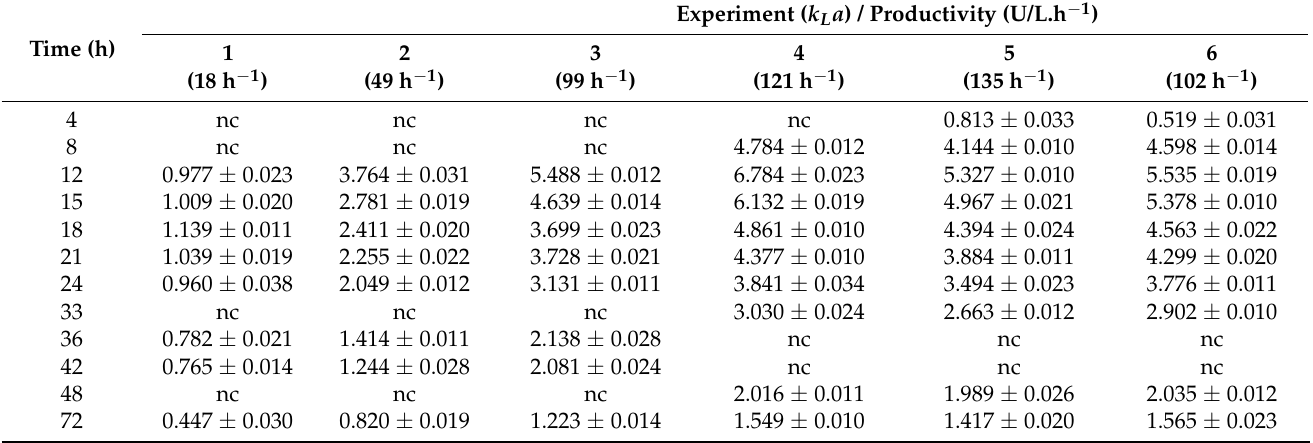
Table 3. Productivity in protease activity ± SD during R. mucilaginosa CBMAI 1528 cultivation in bioreactor up to 72